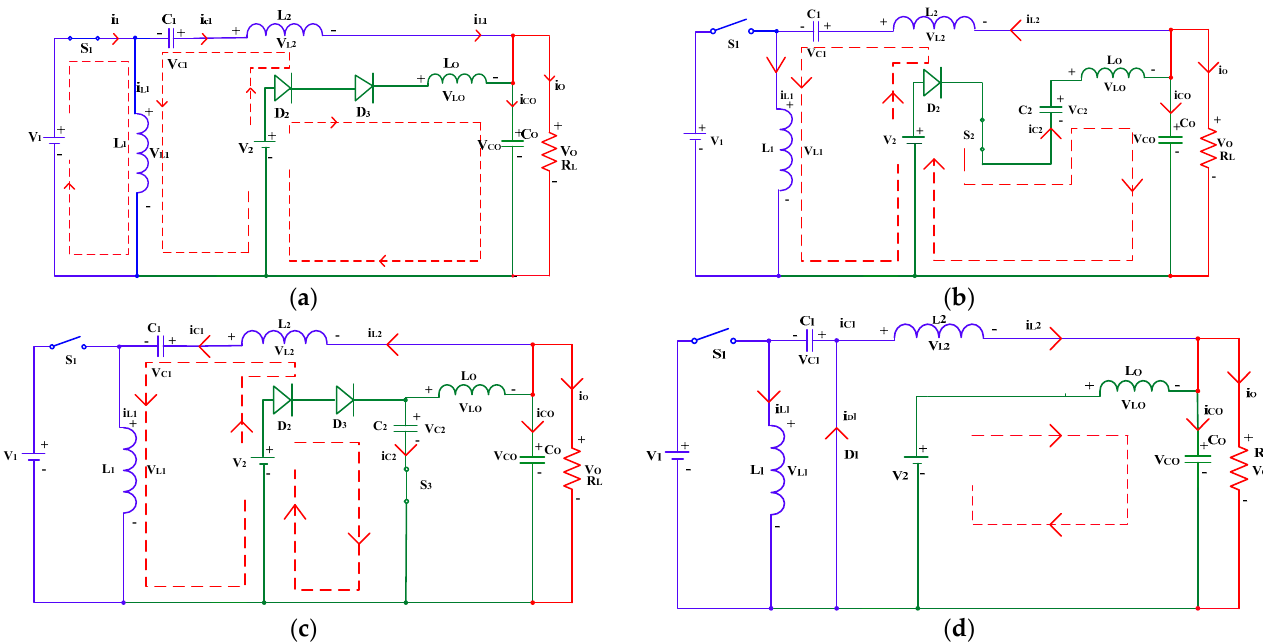
Figure 5. Equivalent circuits of the proposed multiport converter with current directions: ( a ) Mode 1; ( b ) Mode 2; ( c ) Mode 3; and ( d ) Mode